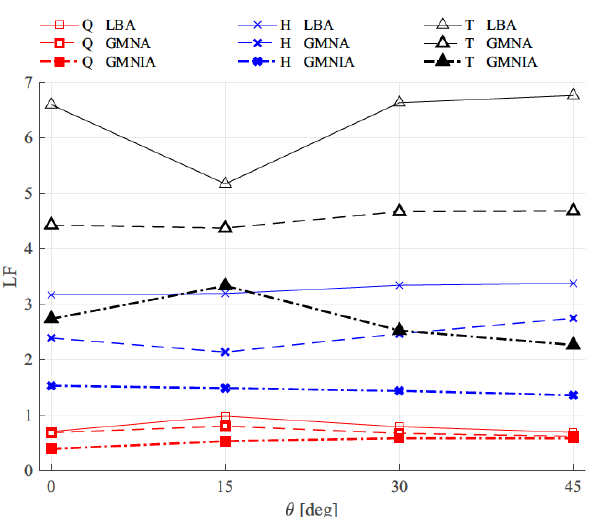
Figure 5: Load Factors obtained from LBA, GMNA and GMNIA for each gridshell